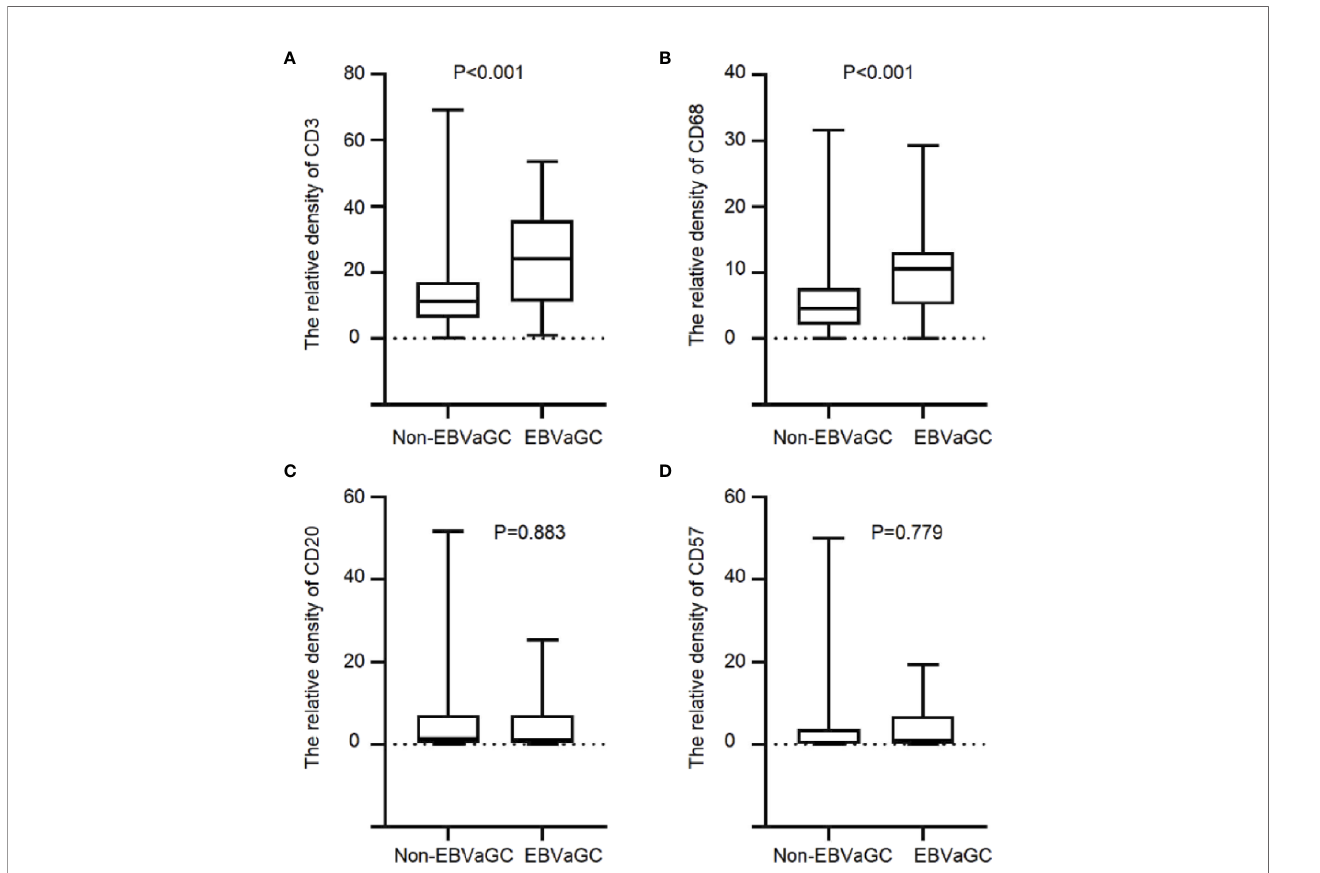
FIGURE 2 | Immune cell in fi ltration in EBVaGC and non-EBVaGC. The panels show the density of (A) CD3 + T lymphocytes. (B) CD68 + macrophages, (C) CD20 + B lymphocytes, and (D) CD57 + NK cells.